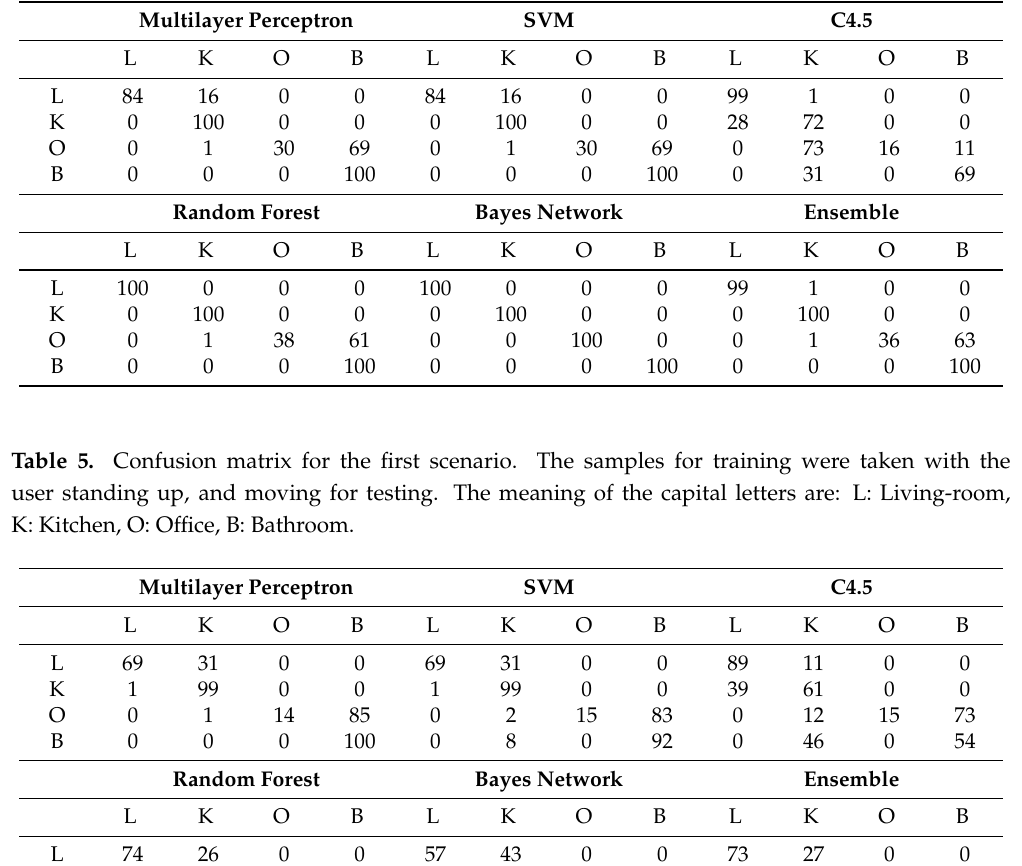
Table 4. Confusion matrix for the first scenario. The samples for training were taken with the user standing up, and also standing up for testing. The meaning of the capital letters are: L: Living-room, K: Kitchen, O: Office, B: Bathroom.